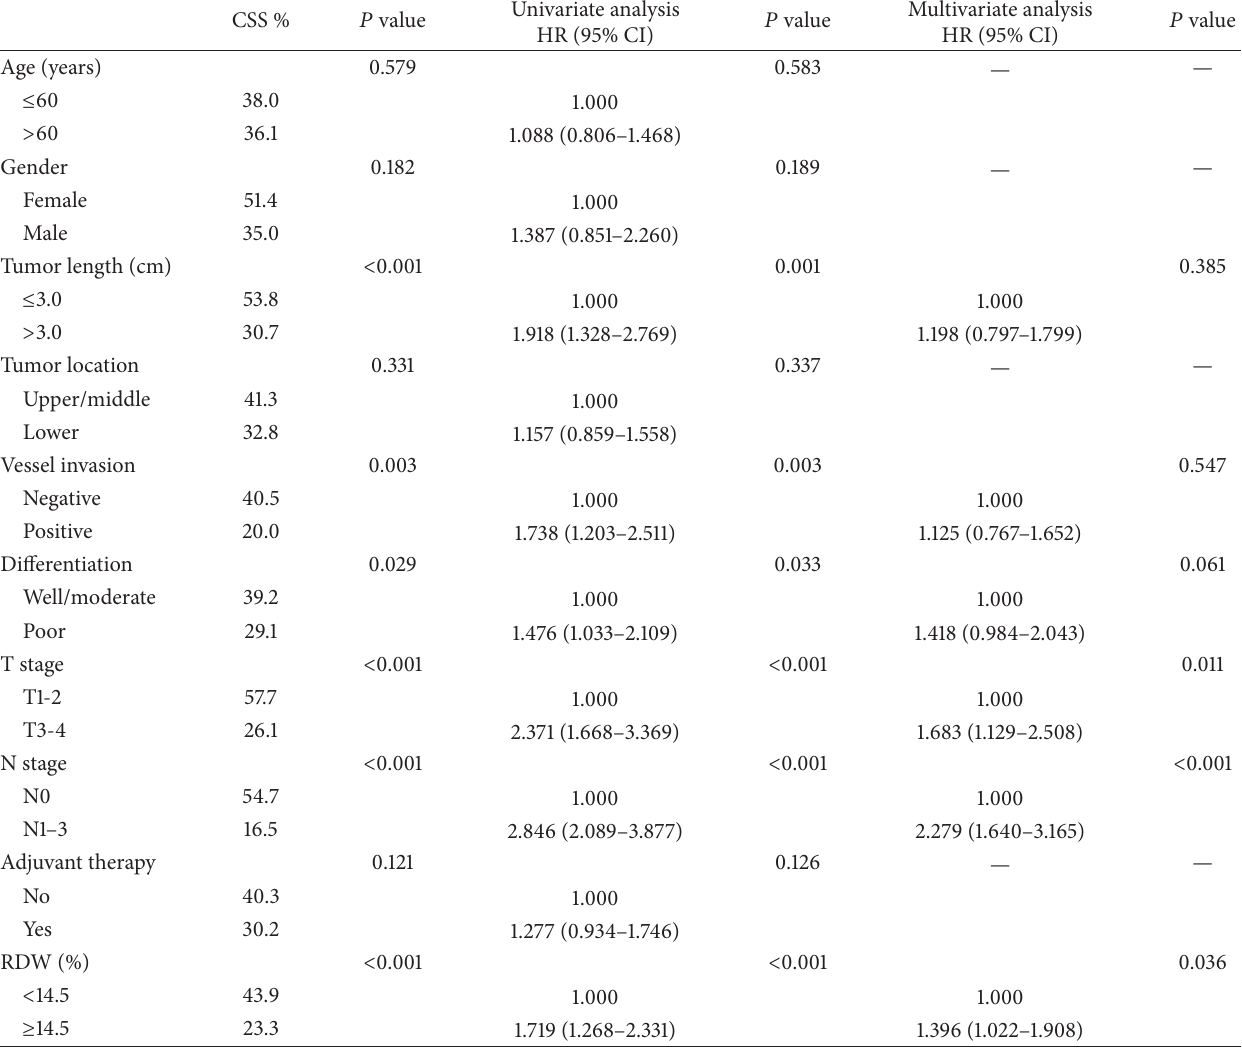
Table 2: Univariate and multivariate analyses of CSS in ESCC